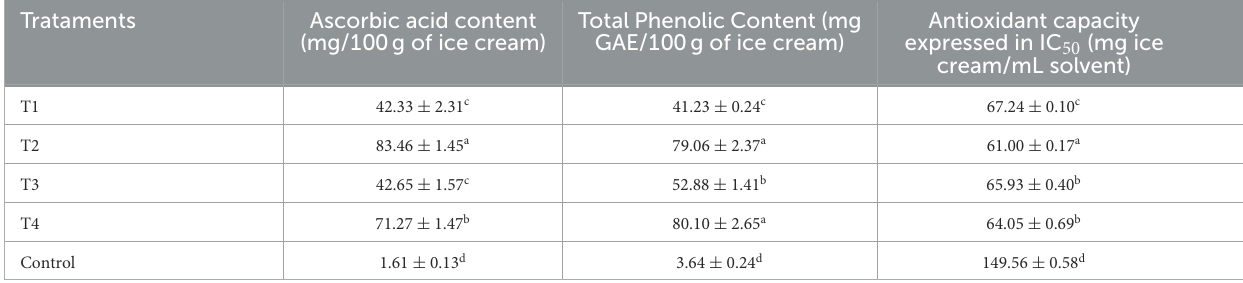
TABLE 4 Ascorbic acid content, total phenolics and antioxidant capacity in ice creams with Mangifera indica and Myrciaria dubia pulps. Trataments